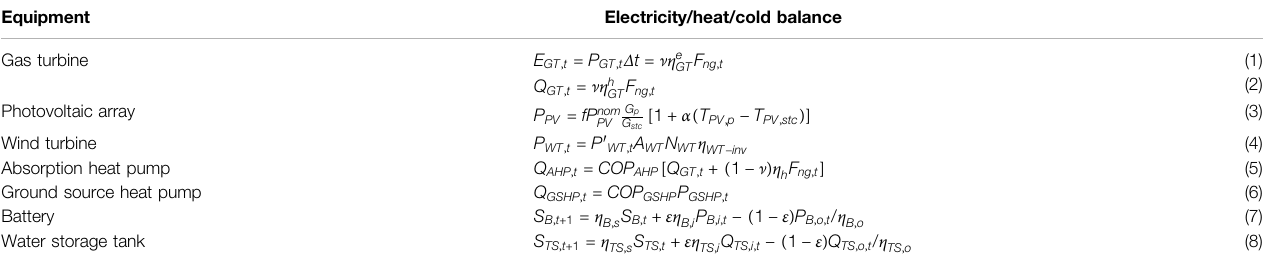
TABLE 1 | Energy principles of components